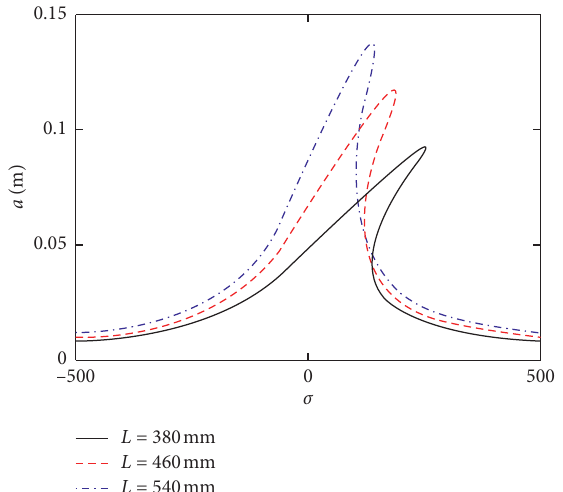
Figure 10: Effect of the length of the cutting bar on primary resonance curves.